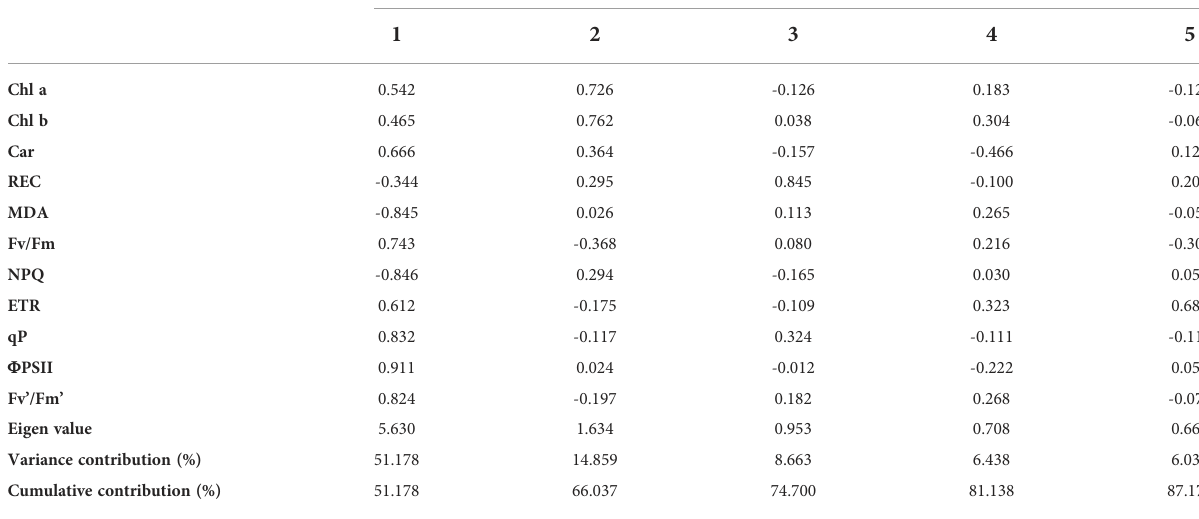
TABLE 1 Variance contribution of the top fi ve principal components and factor load capacity. Traits Principal component